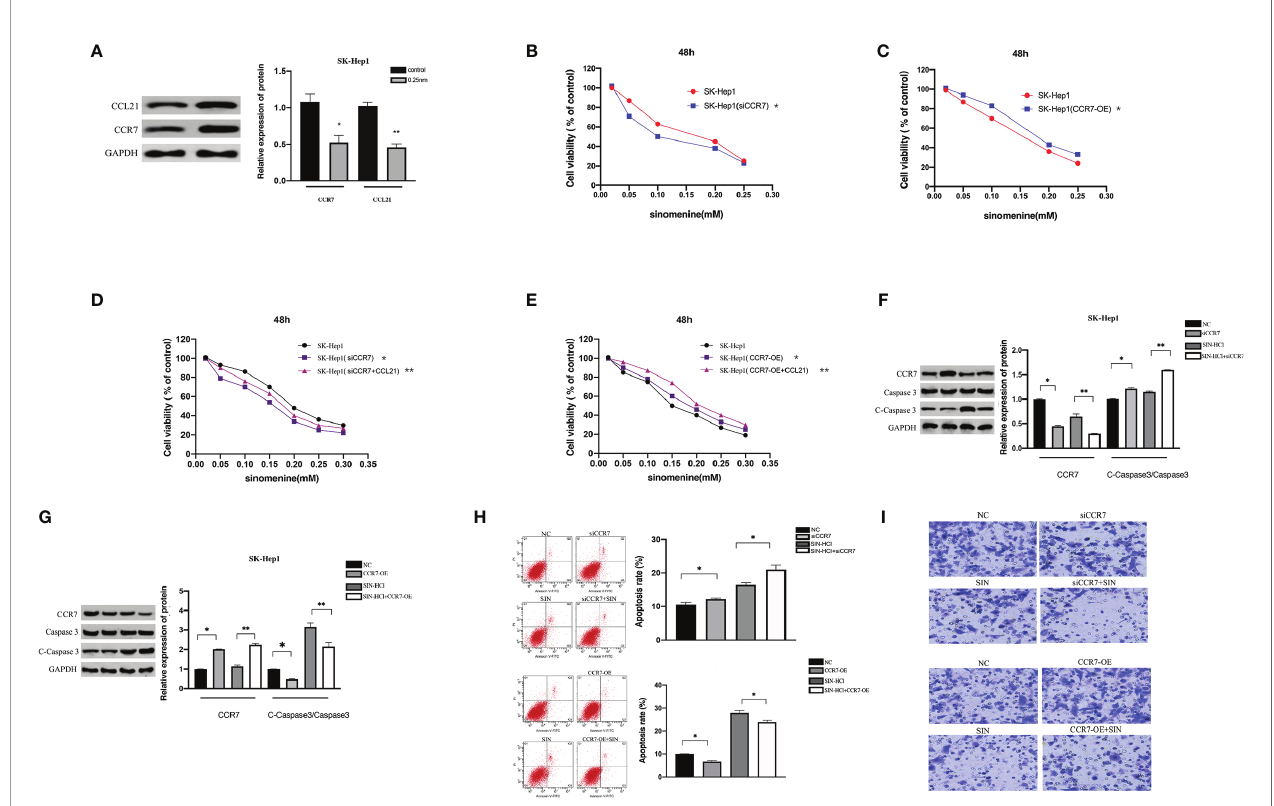
FIGURE 4 | The CCL21-CCR7 axis participates in the effect of sinomenine hydrochloride on HCC cells. (A) WB assay of the expression of CCR7 and CCL21 in SK- Hep1 cells. (B, C) CCK-8 experiments examine the effect of CCR7 knockout and CXCR7-overexpressing cells on cell proliferation. (D, E) CCK-8 experiments on the effect of CCR7-transfected SK-Hep1 cells on cell proliferation in the presence of CCL21 (80 ng/ml). (F, G) WB assay of apoptosis-related protein expression in SK- Hep1 cells. (H) Apoptosis was detected by fl ow cytometry. (I) Transwell assay for cell invasion (×200). *P < 0.05, **P <